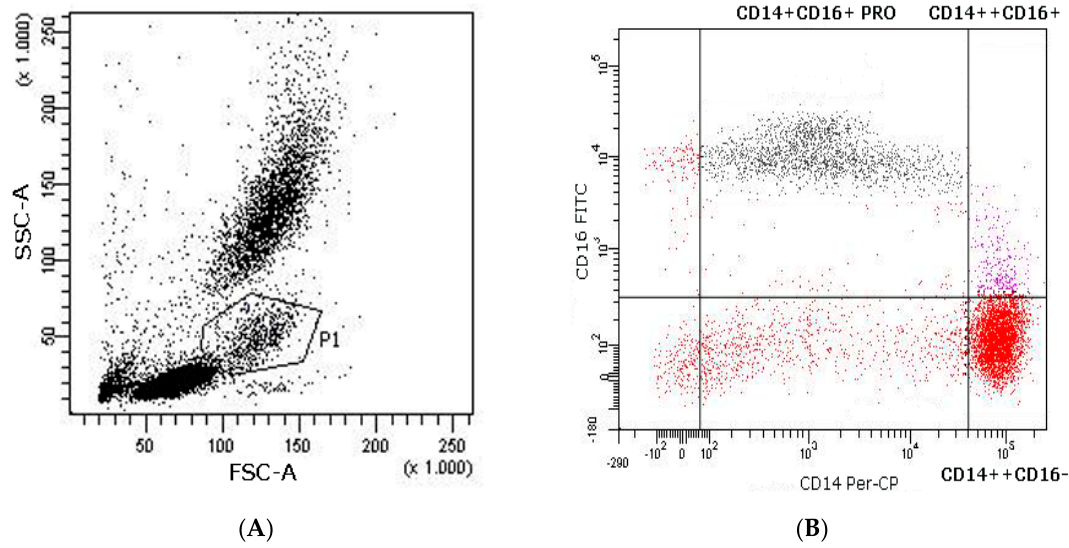
Figure 2. Representative flow cytometry analysis of monocyte subsets in the peripheral blood of a volunteer after an exercise bout. ( A ). Monocytes gated in P1 in FCS-A/SSC-A. ( B ). Monocyte subsets in P1 assessed using a CD14 Per-CP/CD16-FITC dot plot.